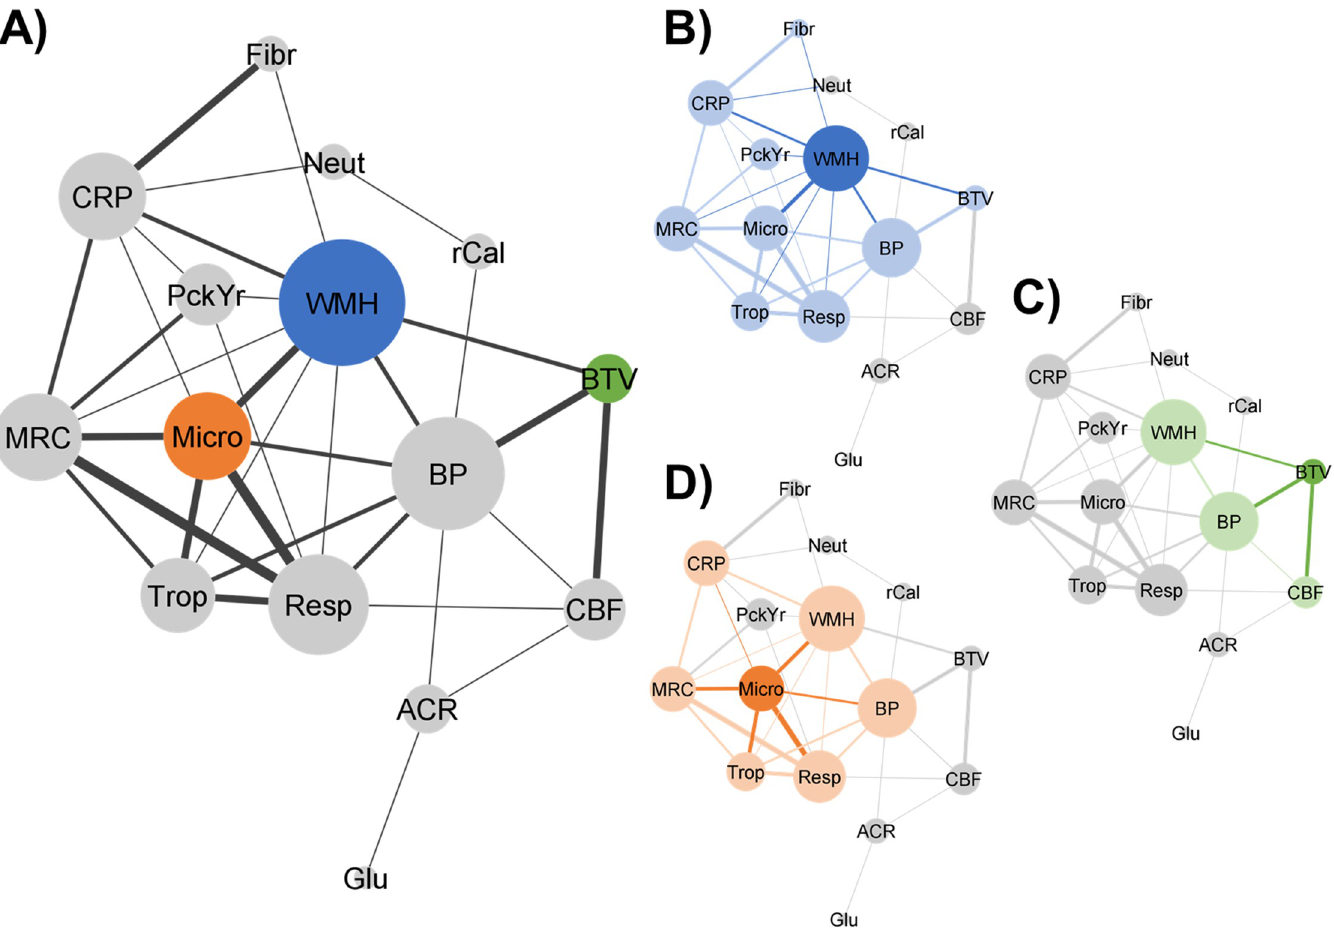
Fig 1. Network diagram. Pearson’s correlations between non-brain and brain measures (circles) are represented as network connections. All lines indicate significance at p < 0.05, line thickness indicates strength of correlation (correlation coefficient). (A) whole network. (B) Brain Tissue Volume (green), (C) white matter hyperintensity volume (blue), (D) White Matter Microstructure (orange). Dark colours show direct correlations with a brain measure. Light colours indicate intercorrelations between non-brain measures. Circle size reflects the number of connections. Relationships with CBF peak height and Plasma Lipids are not shown. ACR = Urine Albumin to Creatinine Ratio, BTV = Brain Tissue Volume, BP = Blood Pressure, CBF = median cerebral blood flow, CRP = high-sensitivity C-Reactive Protein, Fibr = Fibrinogen, Glu = Glucose Dysregulation, Micro = Lower White Matter Microstructure, MRC = MRC dyspnoea, Neut = Neutrophils, PckYr = pack year smoking history, Resp = Respiratory Function, rCal = Retinal Vessel Calibre, rTor = Retinal Vessel Tortuosity, Trop = troponin T, WMH = white matter hyperintense lesion volume.